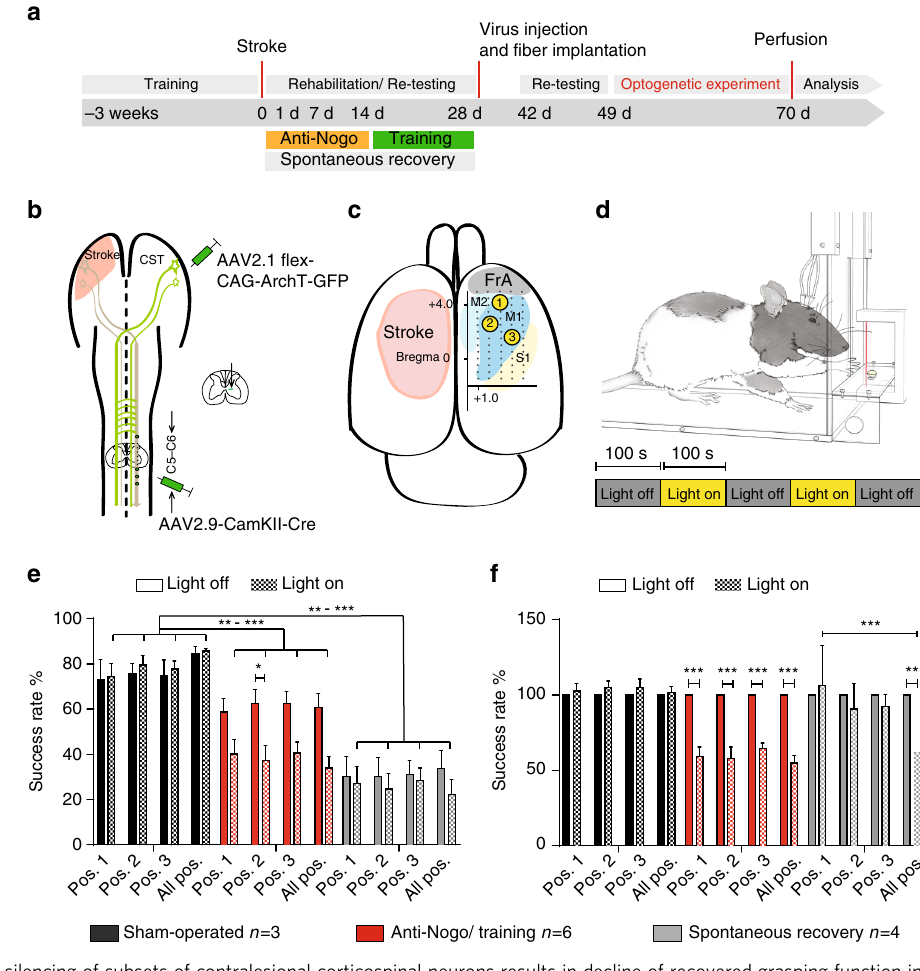
Fig. 5 Optogenetic silencing of subsets of contralesional corticospinal neurons results in decline of recovered grasping function in animals with excellent recovery. a Experimental time schedule. b Scheme of vector injections into the contralesional motor cortex (AAV2.1-Flex-ArchT-GFP) and the stroke denervated cervical spinal cord (AAV2.9-CamKII0.4.Cre.SV40). c Illustration of the location of the three optical fi ber implants: implant #1 is localized in between pre- (M2) and primary motor cortex (M1), implant #2 covers the center of the main forelimb motor cortex (M1), implant #3 lies close to the primary sensory cortex (S1). (FrA frontal area). d Experimental setup for optogenetic inactivation during single pellet grasping: Optical fi bers are connected to the three optical implants covering parts of the pre- and sensorimotor cortex. When the rats start to grasp for the fi rst sugar pellet, a light barrier is activated which, after a lag time of 100 sec, starts the laser for another 100 s. e Optogenetic silencing of rerouted, ipsilaterally projecting corticospinal neurons from the center of the contralesional M1 forelimb motor cortex (Pos. 2/implant #2) results in a signi fi cant decline of the recovered grasping function in animals of the “ Anti-Nogo/Training ” group, while light activation did not perturb grasping performance in control, “ sham-operated ” animals. f Normalizing grasping success rates under “ light-on ” conditions to success rates for “ light-off ” conditions for each individual animal per group con fi rms these results and shows that optogenetic silencing through all three optical fi bers also negatively in fl uences grasping success for the “ Spontaneous recovery ” group. Data are presented as means ± s.e.m.; statistical evaluation was carried out with two-way ANOVA repeated measure followed by Bonferroni post hoc for d and e , asterisks indicate signi fi cances: * p < 0.05, ** p < 0.01, and *** p <